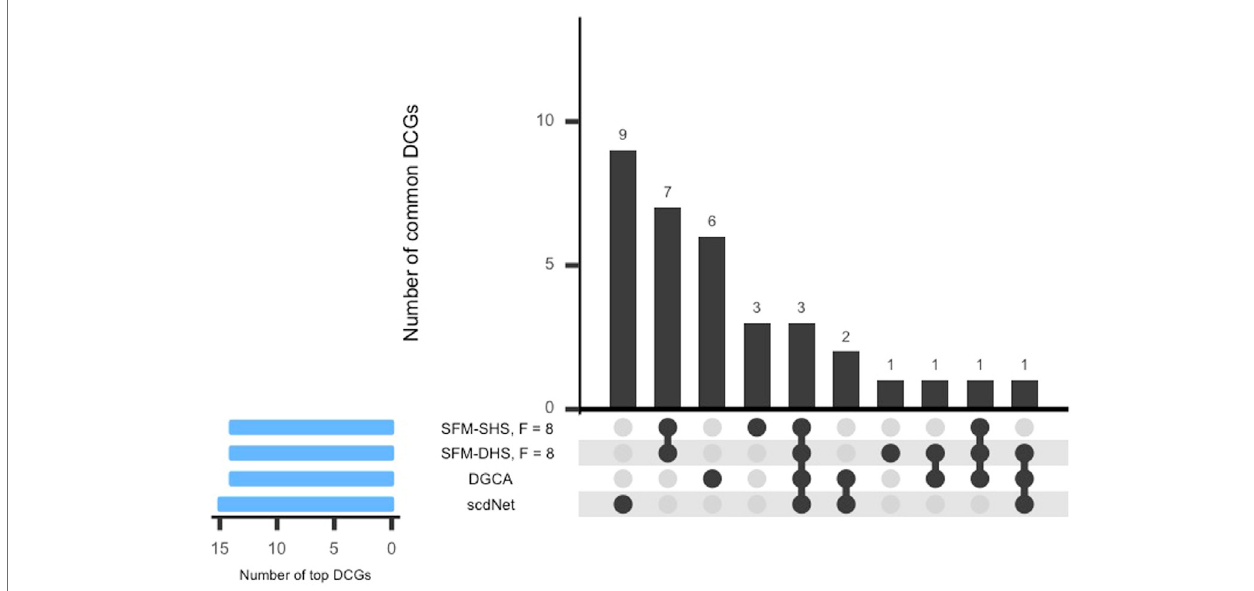
FIGURE 5 | UpSet plot of the top DCGs determined by four differential network methods in the SARS-CoV-2 case study dataset. Results displayed for SFM-SHS and SFM-DHS are from the bootstrap estimation procedure.